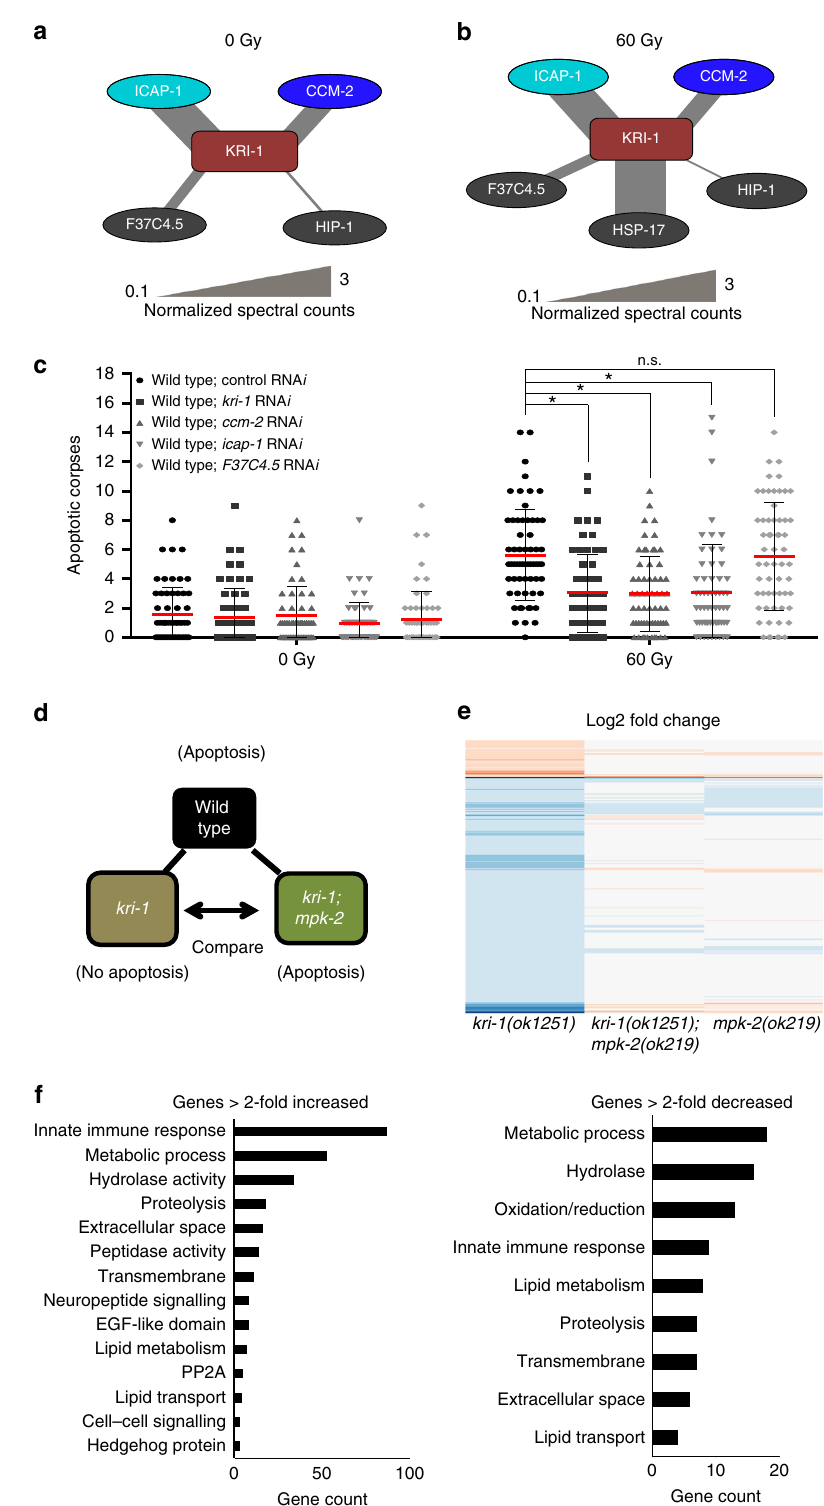
Fig. 4 KRI-1 interacts with CCM-2, ICAP-1, and regulates transcription. a , b KRI-1 interacting partners identi fi ed by AP-MS. Line thickness represents normalized spectral counts. c IR-induced germline apoptosis scored in wild type, wild type; kri-1 RNA i , wild type; ccm-2 RNA i , wild type; icap-1 RNA i , and wild type; F37C4.5 RNA i animals ( n ≥ 60). Red line is mean ± standard deviation. * P < 0.05, two-sided, unpaired t -test. d Schematic of mRNA sequencing. e Heat map depicting relative transcript expression in kri-1(ok1251), mpk-2(ok219) , and kri-1(ok1251); mpk-2(ok219) animals compared to wild type. Red represents down-regulated transcripts, and blue represents up-regulated transcripts. f DAVID was used to group transcripts altered in kri-1(ok1251) mutants based upon gene ontology